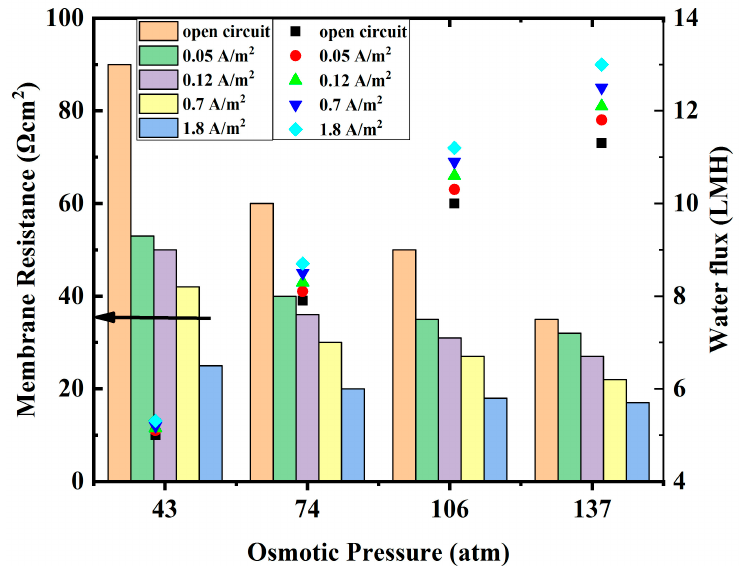
Figure 8. The effect of current and osmotic pressure on membrane resistance and water flux.